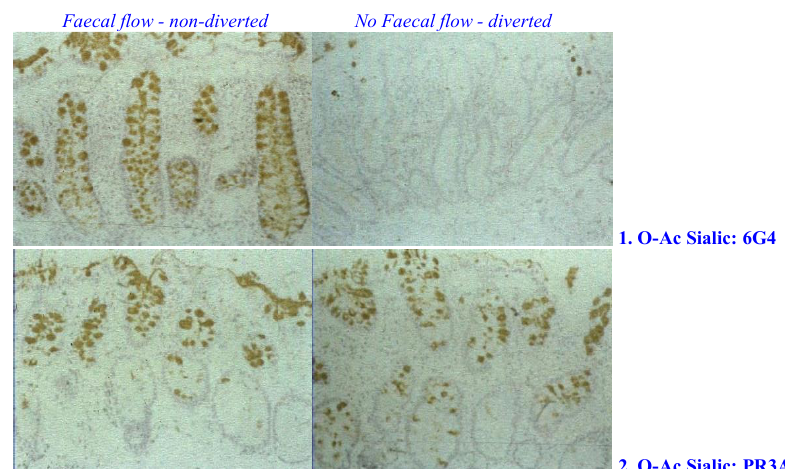
Figure 5. Modulation of Glycan expression after Faecal Diversion. Human colic tissue samples were stained using the antibodies for the epitopes indicated. Note that 1 and 2 represent different antibodies that bind to O -acetylated sialic acids. Analysis of sialic acid O -acetylation revealed an interesting pattern depending which reagent was used. The mPAS method showed no differences, neither did the PR3A5 antibody, however a loss was detected with the 6G4 antibody. The specificity of the PR3A5 and 6G4 antibodies has not been determined, but the result indicates that there is a specific population of O -acetylated sialic acids in colonic mucins that is deleted as a result of faecal diversion (Table 7 and Figure 5). This may relate to the Sd a antigen, which would represent a selective population of glycan sialic acids, which are O -acetylated and are known to be deleted in colorectal cancer (see below). This remains to be examined. The situation for sialic acid non- O -acetylators remains to be